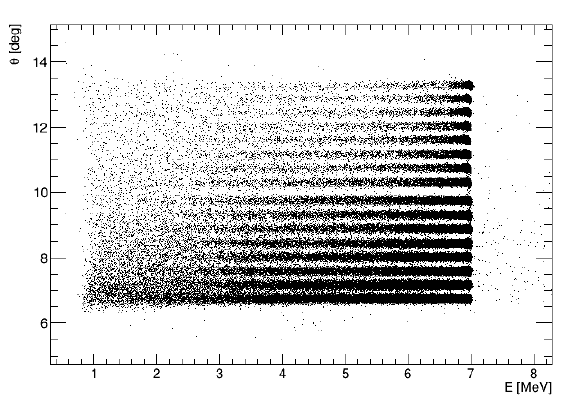
Figure 3. PSD1 angle vs. energy plot after position and energy calibration.